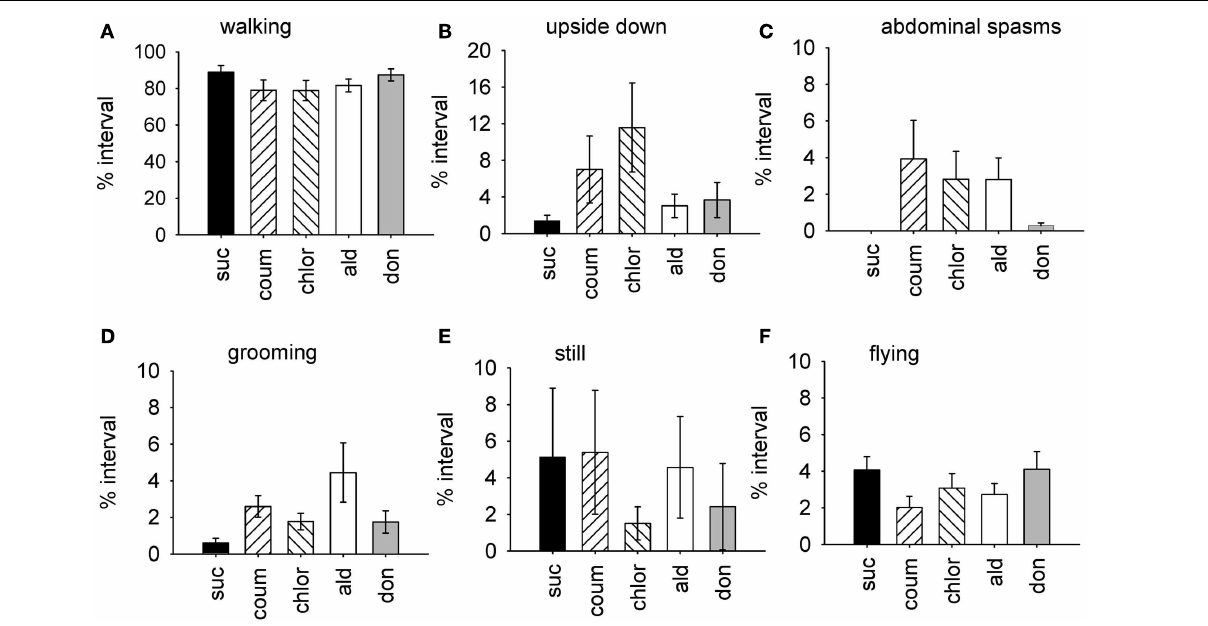
FIGURE 1 |Time budget data for all behaviors from bees treated with AChE inhibitors. Graphs show the mean percentage of the observation interval ( ± SEM) spent engaged in different types of behavior. (A) Walking, (B) upside down, (C) abdominal spasms, (D) grooming (includes both head and